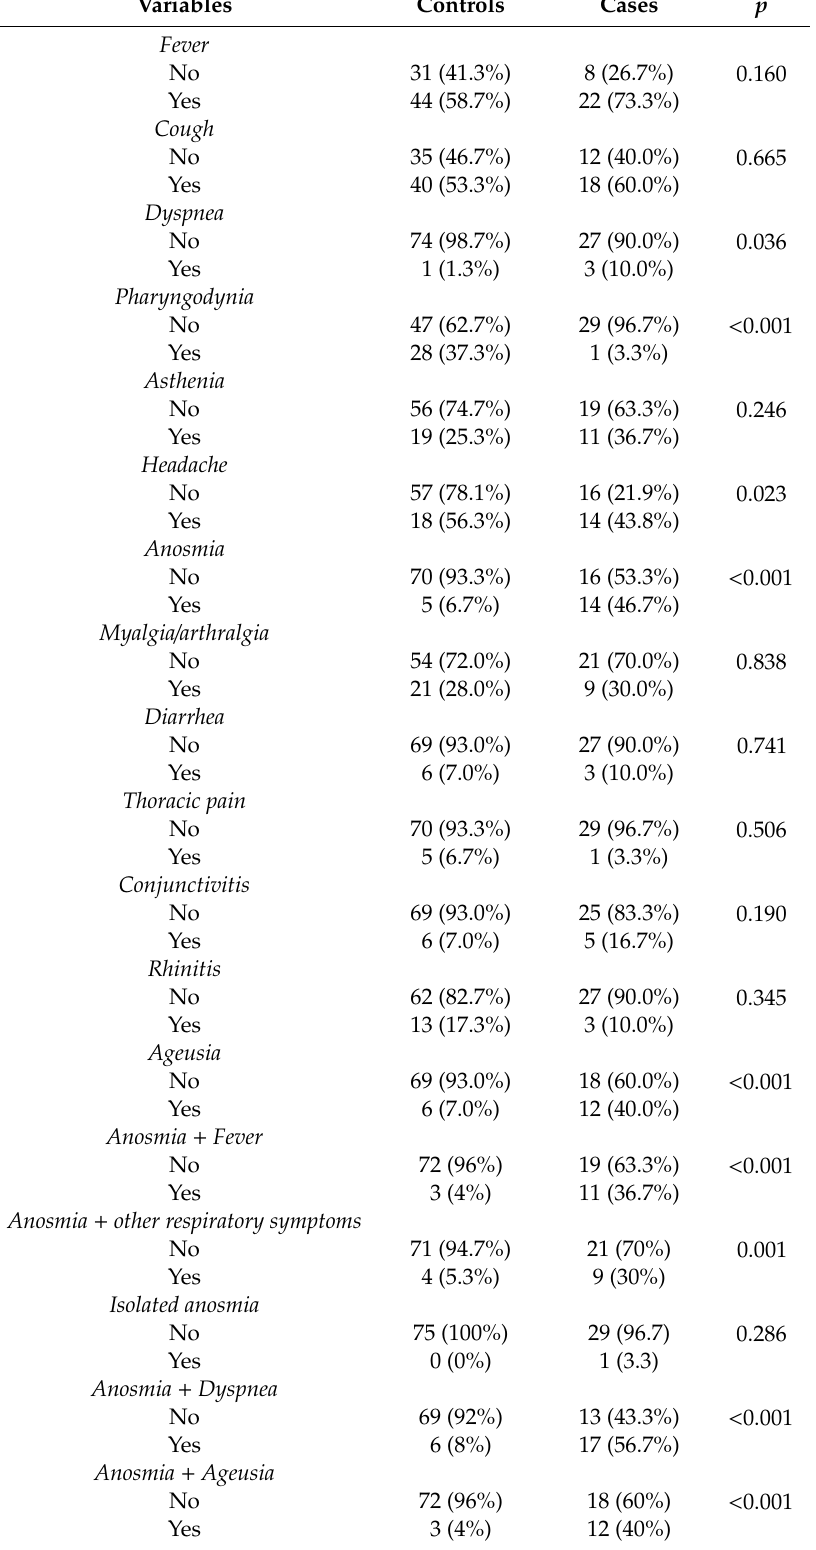
Table 2. Clinical characteristics of the study